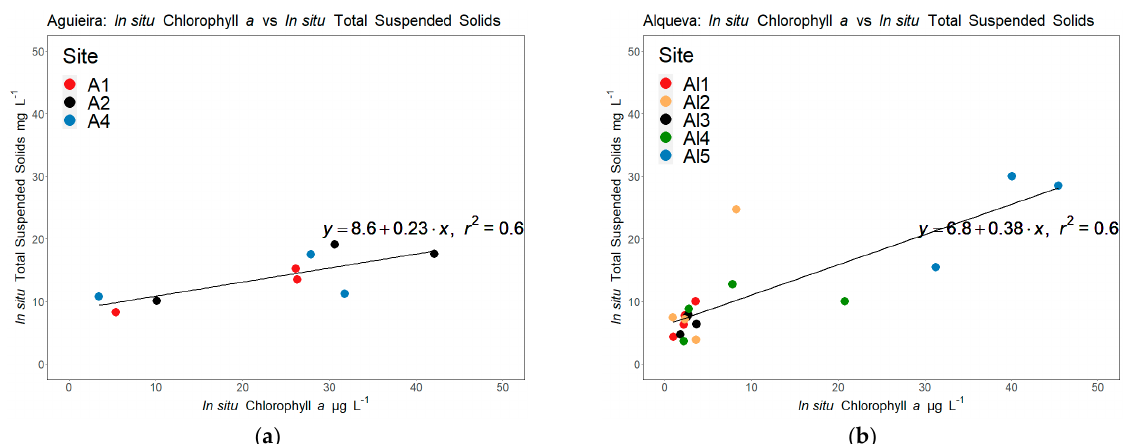
Figure 4. Scatter plots between in-situ data of chlorophyll a ( μ g L − 1 ) and total suspended solids (mg L − 1 ) in ( a ) Aguieira and ( b ) Alqueva.